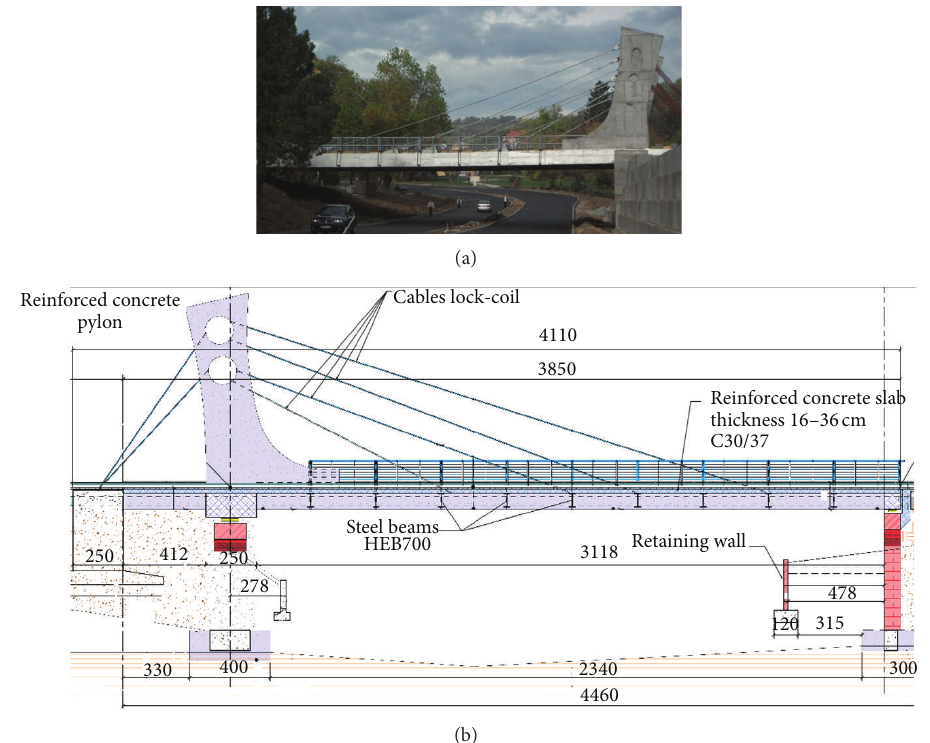
Figure 29: Cable-stayed overpass in Tuzla: (a) view, (b) longitudinal cross section.